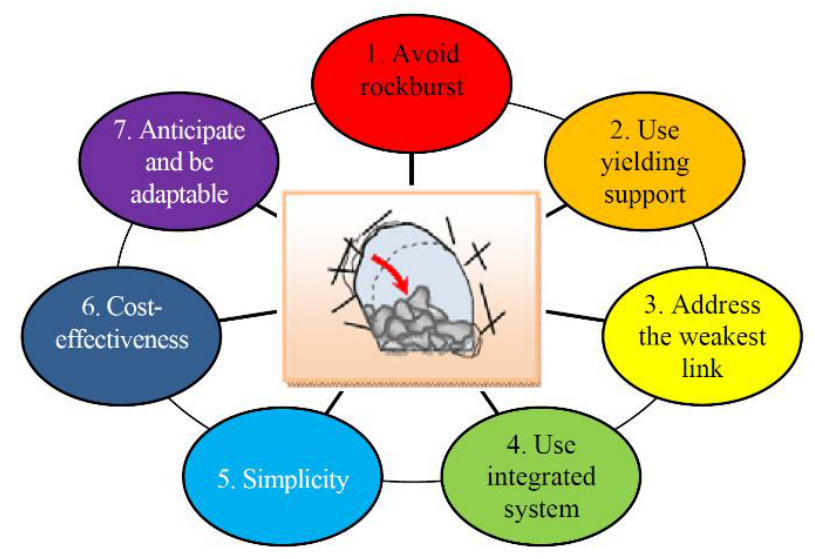
Figure 11. Seven rockburst support design principles (from [30]).